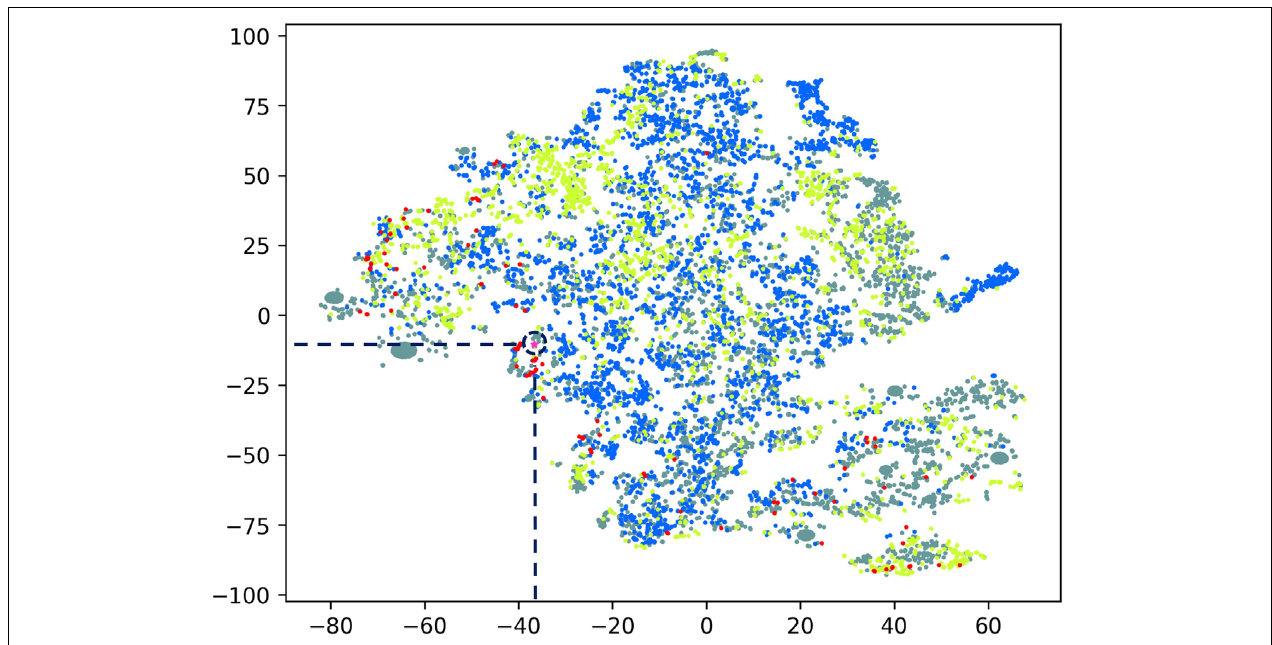
FIGURE 2 | T-distributed Stochastic Neighbor Embedding (t-SNE) plot comprising all peptide data used in this study. Peptide sequences were transformed using all physiochemical features, averaged by peptide length. Gray: non-active peptides; yellow: active peptides; blue: peptides from mass spectrometry; red: top active peptides; Pink star: NuriPep 1653 (identified with a navy blue broken